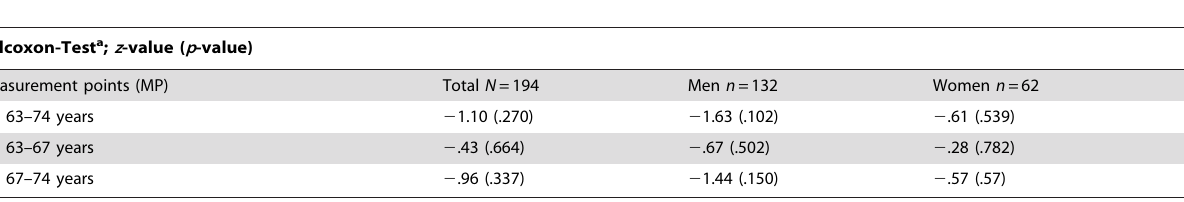
Table 3. Levels of satisfaction with sexual activity: results of the analysis of differences between the measurement points (MP).